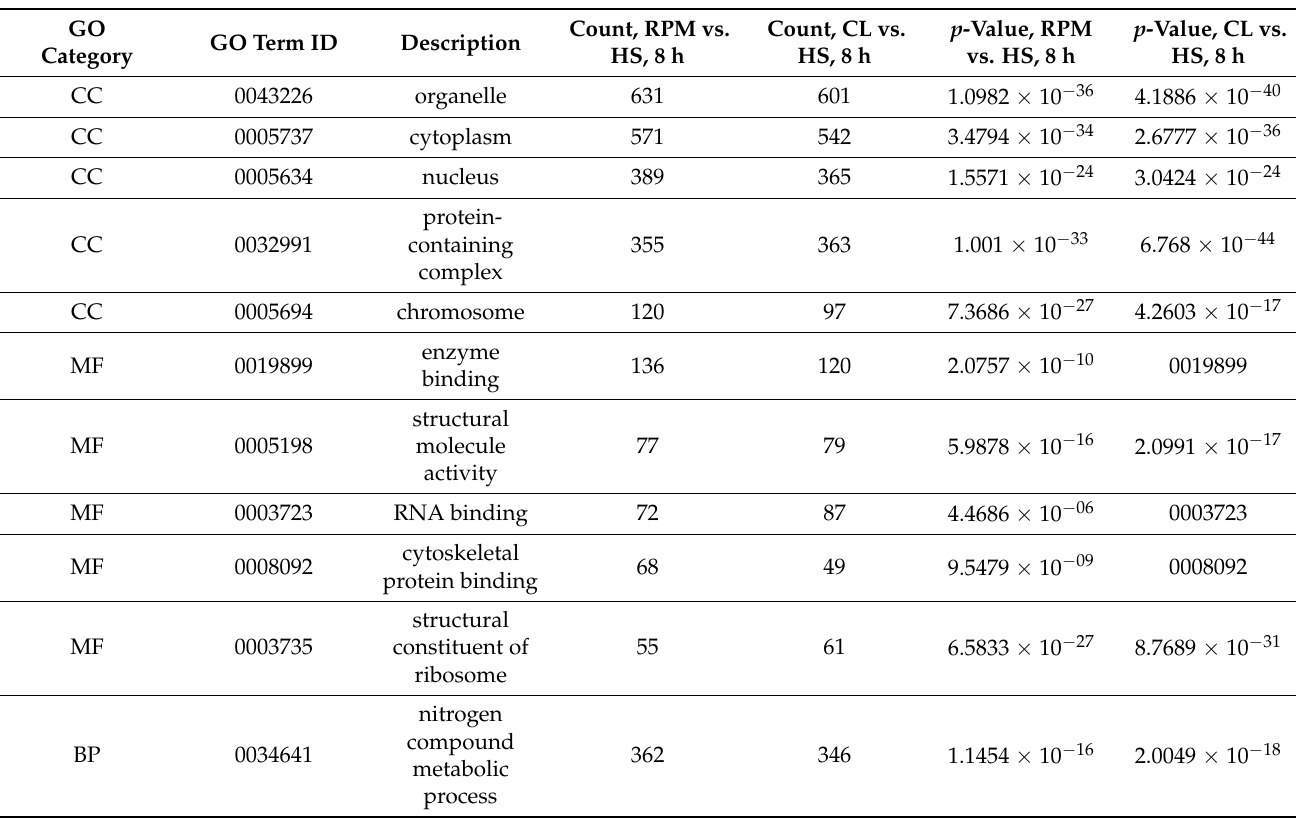
Figure A3. Candidate marker genes discriminating T cell transcriptome responses: Selected differ- entially expressed genes of actin cytoskeleton network and related genes can be used as potential markers for the response of T cells to simulated microgravity (MG) platforms (clinostat and random positioning machine (RPM)), and to hydrodynamic stress (HS). Table A1. Top five common Gene Ontology (GO) terms at 8 h of simulated microgravity in RPM and CL versus hydrodynamic stress (HS) treatment for three categories of GO enrichment analysis: cellular component (CC), molecular function (MF), and biological processes (BP).